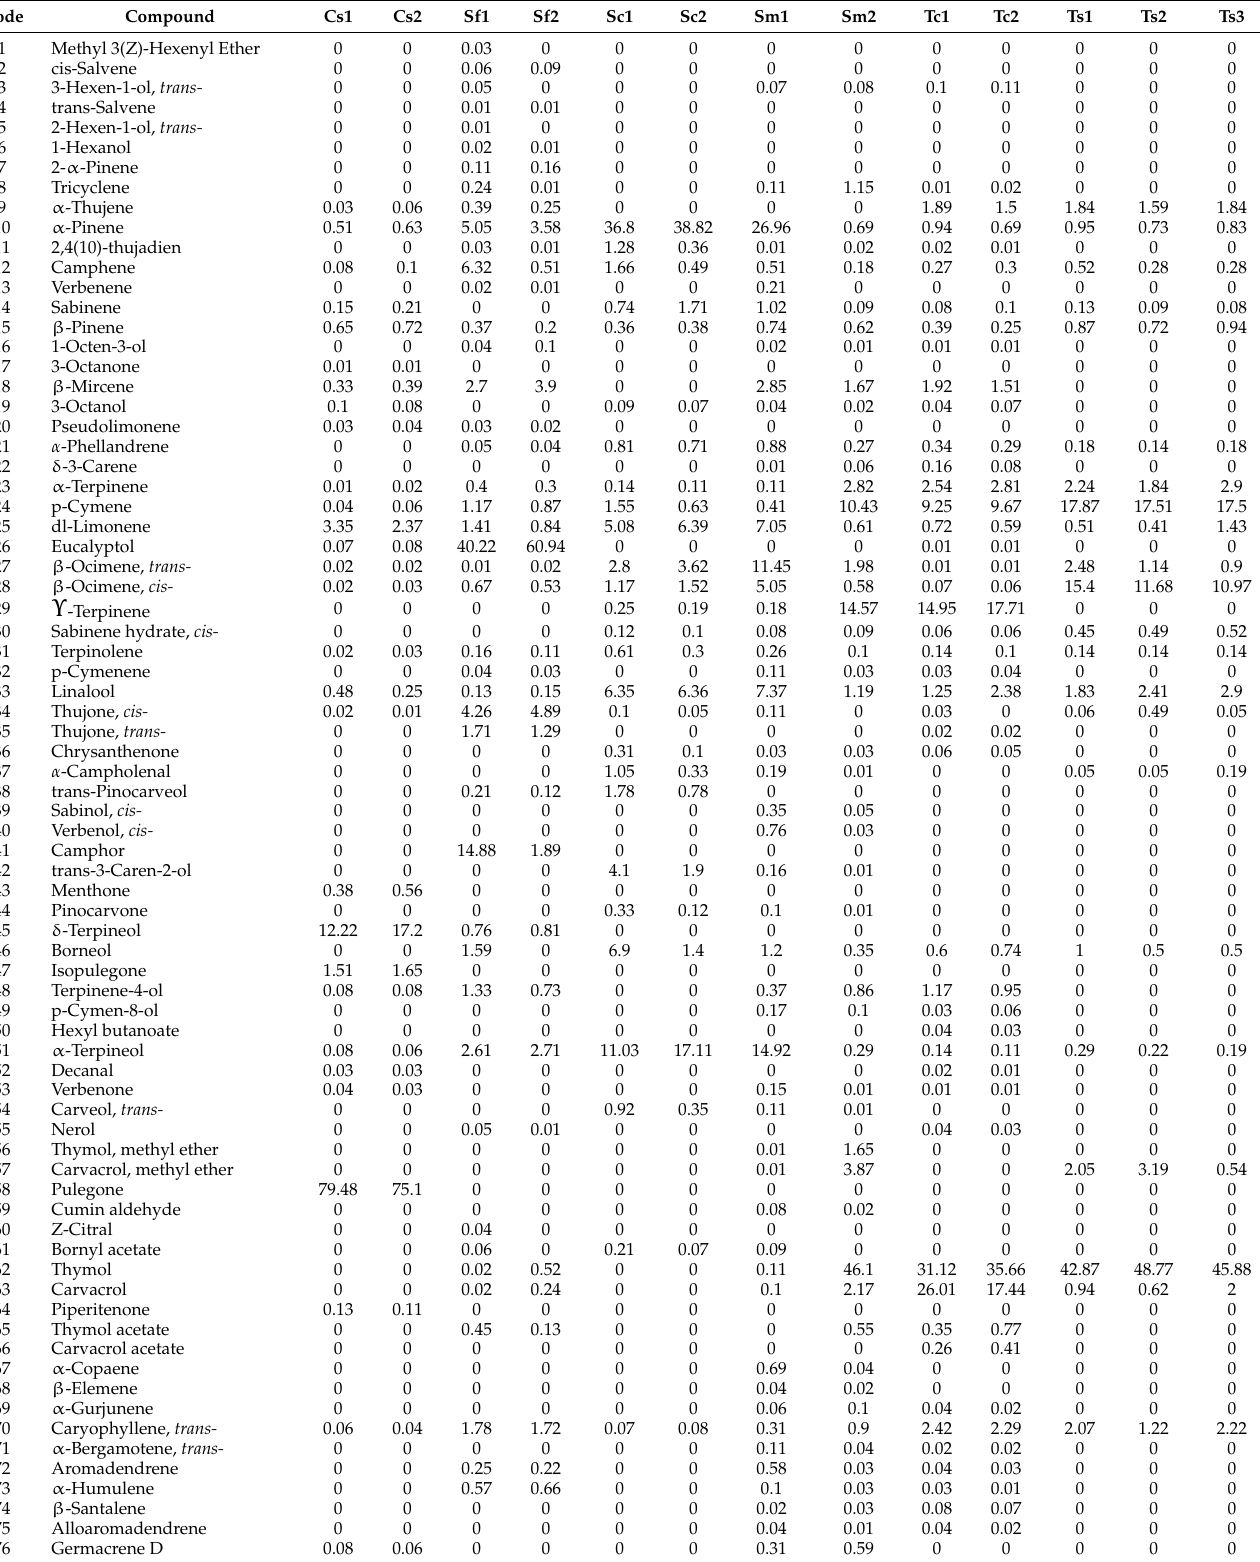
Table 2. EOs chemical composition percentage of Clinopodium suaveolens (Cs), Salvia fruticosa subsp. thomasii (Sf), Satureja cuneifolia (Sc) Satureja montana subsp. montana (Sm), Thymbra capitata (Tc), and T. spinulosus (Ts)